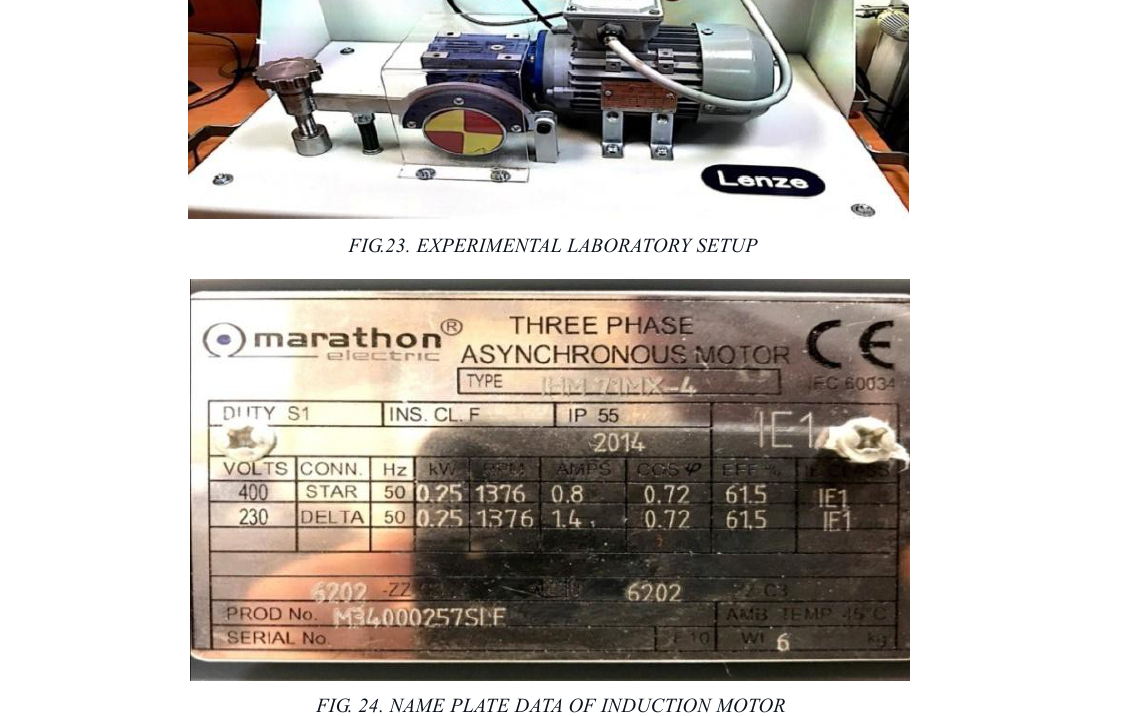
FIG. 24. NAME PLATE DATA OF INDUCTION MOTOR